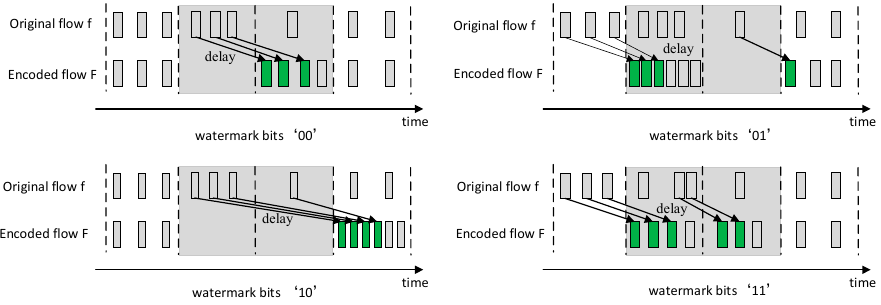
Figure 3. The schematic diagram of the watermark encoding.